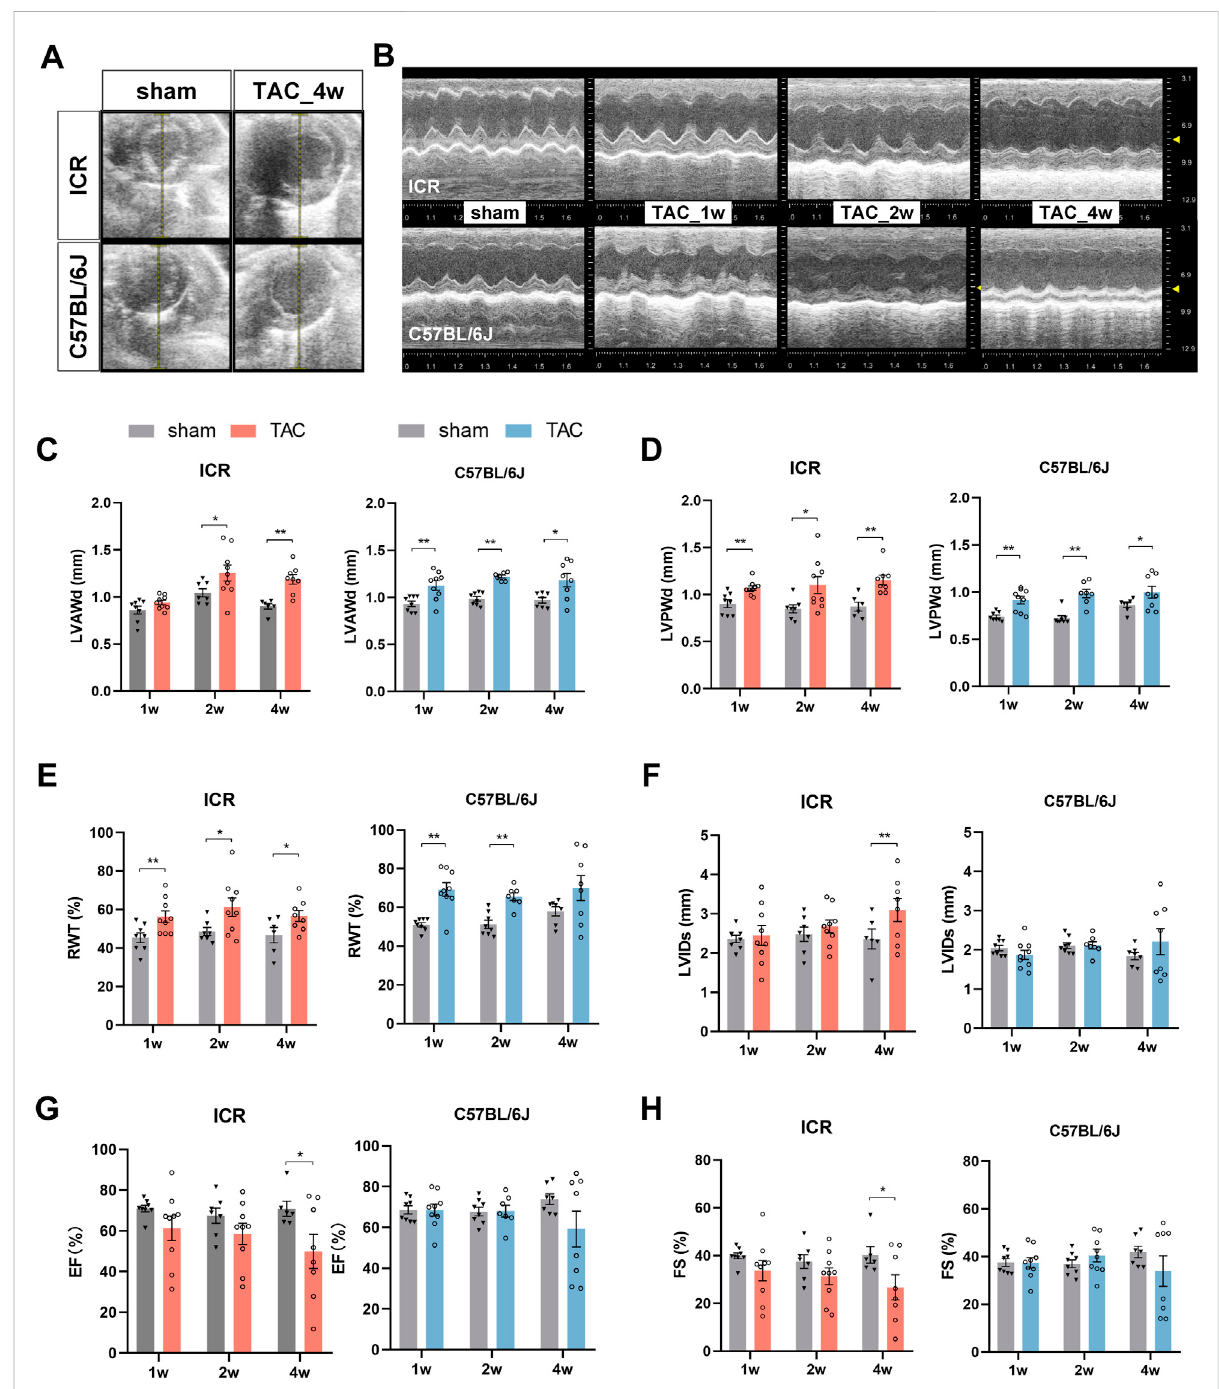
FIGURE 2 Echocardiography at 1, 2 and 4 weeks post-TAC or sham surgery in ICR and C57BL/6J mice. (A,B) Representative ultrasound images of left ventricle (short-axis, at the level of the papillary muscles) from ICR and C57BL/6J mice: (A) in B-mode; (B) M-mode. (C – H) Averaged parameters obtained from analysis of echocardiograms: (C) Left ventricular anterior wall thickness at end-diastole (LVAWd); (D) LV posterior wall thickness at end-diastole (LVPWd); (E) Relative Wall thickness (RWT) = (LVAWd + LVPWd)/LVIDd×100%. (F) LVID at end systole (LVIDs); (G) Ejection fraction (EF); (H) Fractional shortening (FS); Values represent mean ± SEM, N = 6 – 9 per ICR group, N = 7 – 9 per C57BL/6J group. * p < 0.05, ** p <